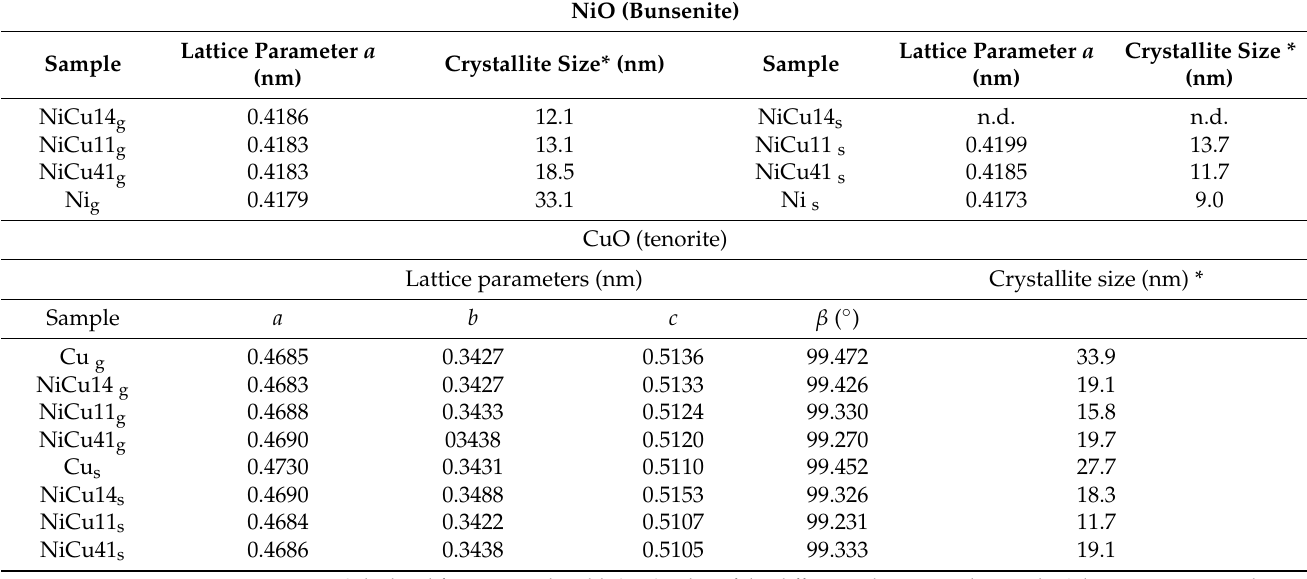
Table 3. Crystallite sizes and lattice parameters of oxide phases (NiO and CuO) in the granular and sputtered Ni-Cu catalysts.